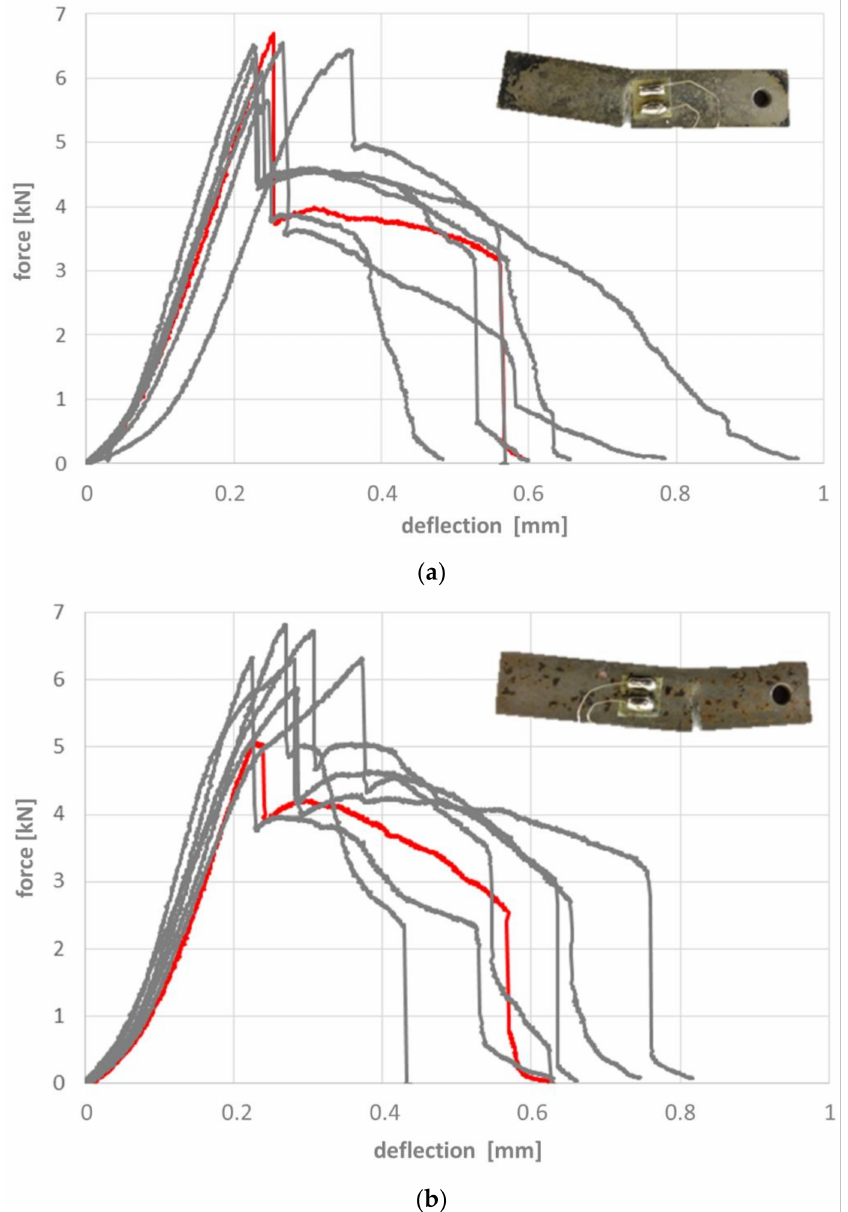
Figure 12. Force-deflection curves for samples without hollow glass microspheres, ( a ) carburized, and ( b ) carbonitrided. Inserts show the samples corresponding to the red curve. Note the difference in scale of both